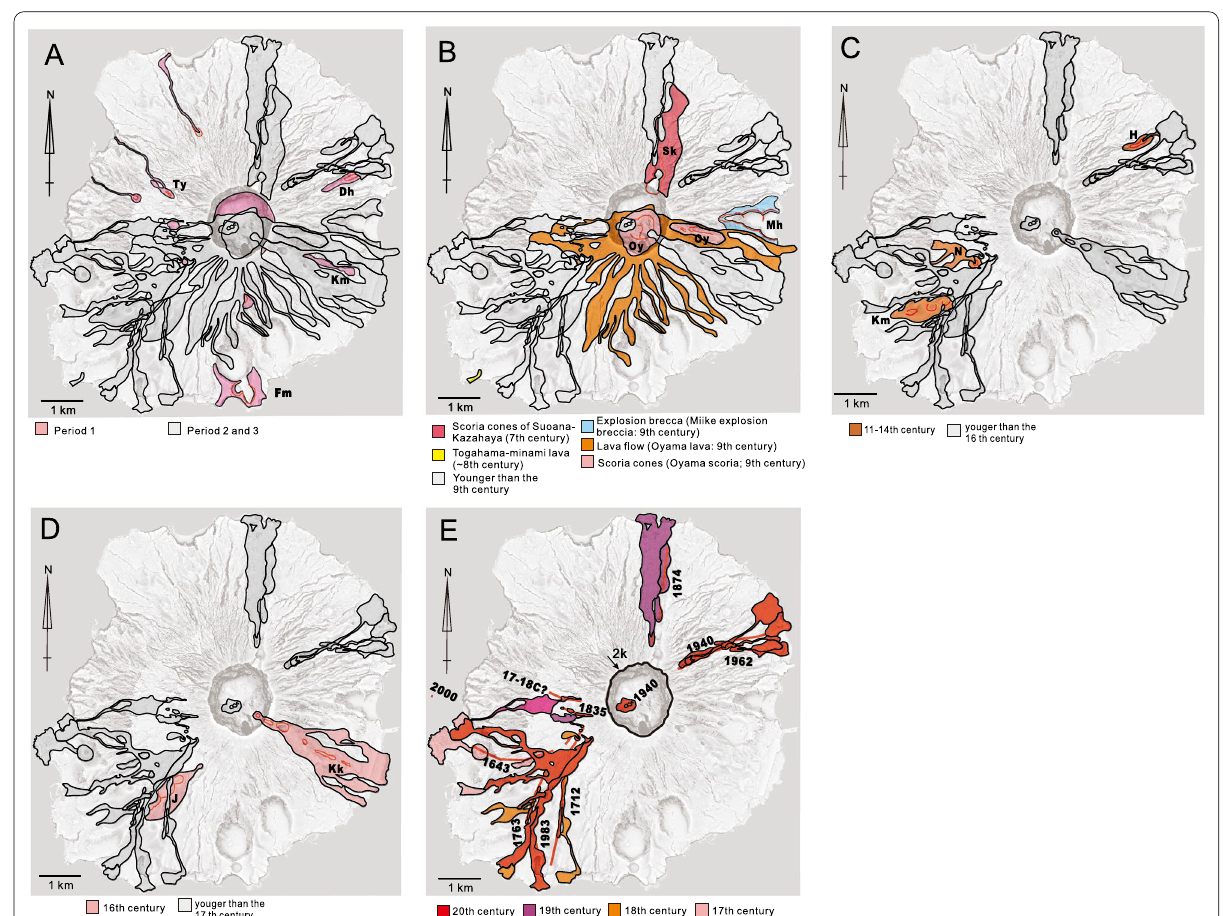
Fig. 6 Distributions of the eruption products (lava flows and scoria cones). The hill-shade map uses the topography after the 2000 AD eruption. A Period 1 products between 2.3 ka and seventh century. Representative lateral eruption fissures are shown. Kanasominami (Km), Tairayama (Ty), Furumio (Fm), Daihannyayama (Dh). B the eruption products between seventh and ninth century (Period 2). Suoana–Kazahaya (Sk), Oyama (Oy), Miike (Mh). C The eruption products between the ninth and fourteenth centuries. Kamane (Km), Nanto (N) and Hinoyamatouge (H) in Period 2. D The eruptions of Jinanyama (J) and Kamakata (Kk) possibly in the sixteenth century (beginning of Period 3). E The eruptions between the seventeenth and twentieth centuries (Period 3) with their eruption age. “2k” indicate the caldera rim formed by the 2000 AD